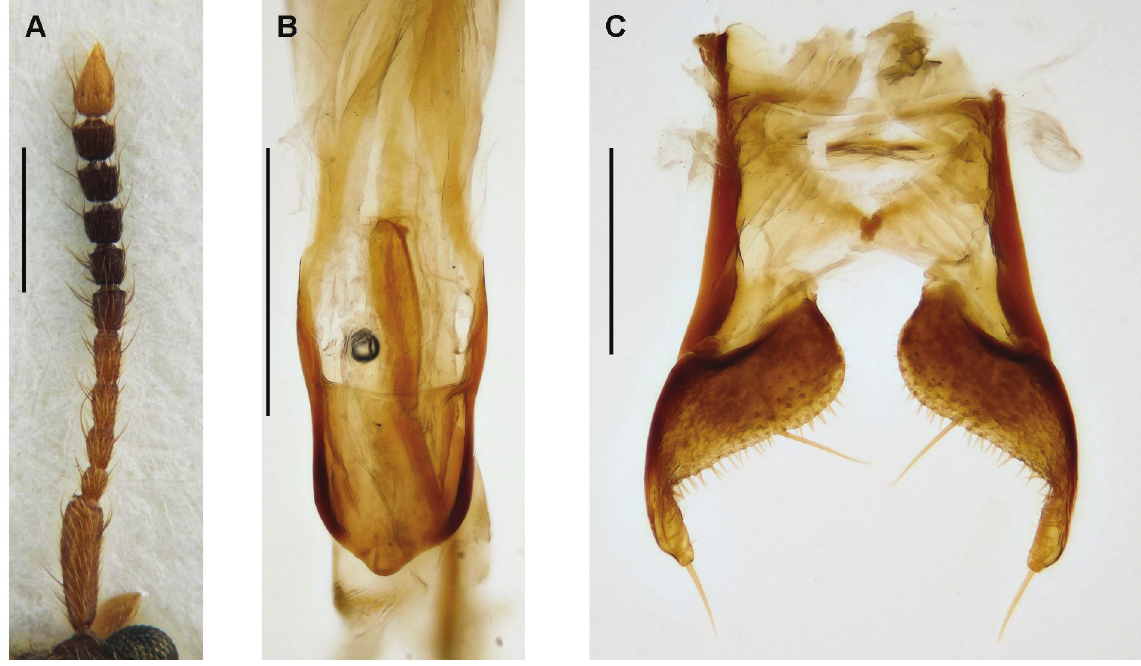
Fig. 5. Psammoecus grandis Grouvelle, 1908. A . Right antenna. B . Median lobe. C . Parameres. Scale lines = 0.5